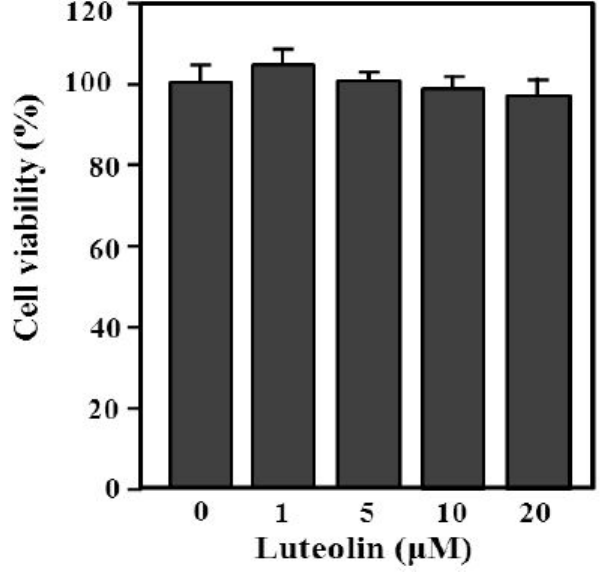
Figure 2. Effect of luteolin on HMC-1 cell viability. Cells (5 × 10 5 ) were treated